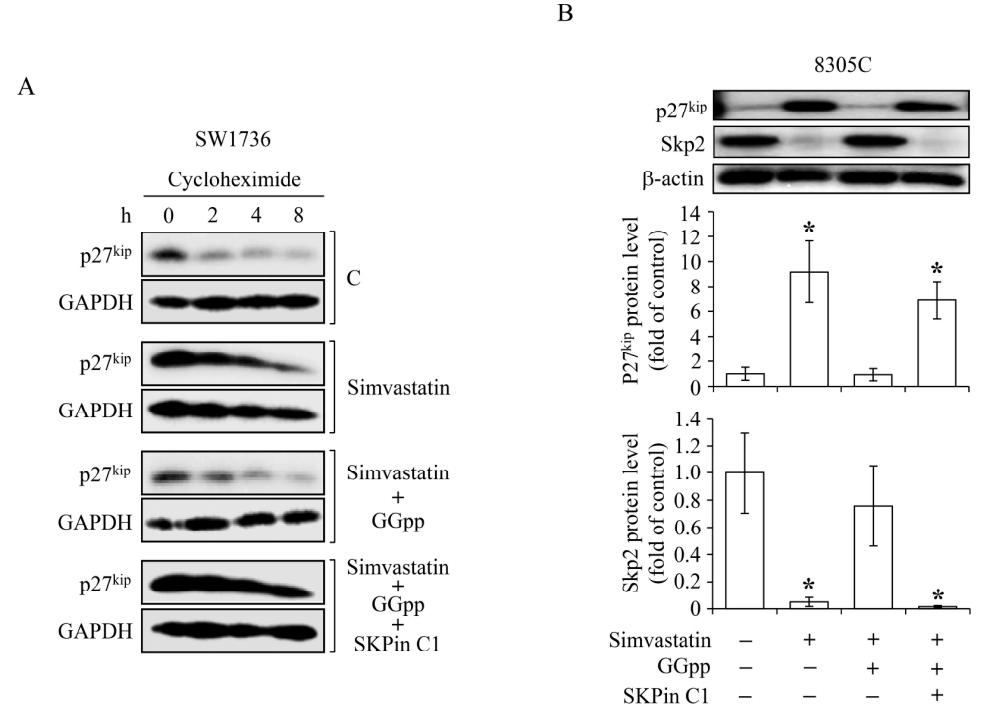
Figure 5. Effects of simvastatin on p27 kip protein stability in ATC cells. ( A ) Cycloheximide-induced degradation of p27 kip protein in SW1736 cells was retarded by simvastatin (10 μ M), and the effect caused by simvastatin was revoked by GGpp (20 μ M). The effect of add-in GGpp on p27 kip protein stability was eliminated by SKPin C1 (5 μ M). Cells were incubated with DMSO or simvastatin for 40 h followed by cycloheximide incubation for additional 2–8 h. The p27 kip protein levels were then analyzed. ( B ) Simvastatin-augmented p27 kip protein level was eliminated by GGpp, and the effect caused by GGpp treatment was abolished by incubation of 8305C cells with SKPin C1. Cells were pre-incubated with GGpp and/or SKPin C1 for 30 min followed by simvastatin incubation for additional 48 h. The p27 kip and Skp2 protein level was then analyzed. Values represent the means ± SEM ( n = 3). * p < 0.05, different from corresponding control. GAPDH or β -actin proteins served as controls for equivalent loading. C, control.